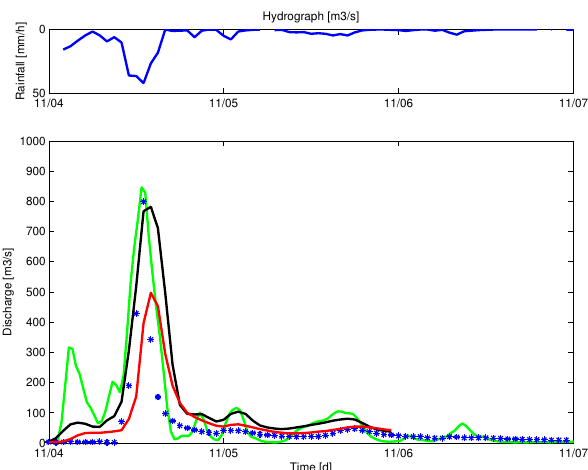
Figure 12. Solid lines represent the result of the simulations forced with observed rainfall for the episode of 4 November for RIBS (green), DRiFt (black) and HBV (red) models. Observations at the Passerella Firpo gauging station are represented by blue dots, while average rainfall over the basin is represented by the solid blue line in the upper plot. Observations and simulations are represented with a temporal resolution of